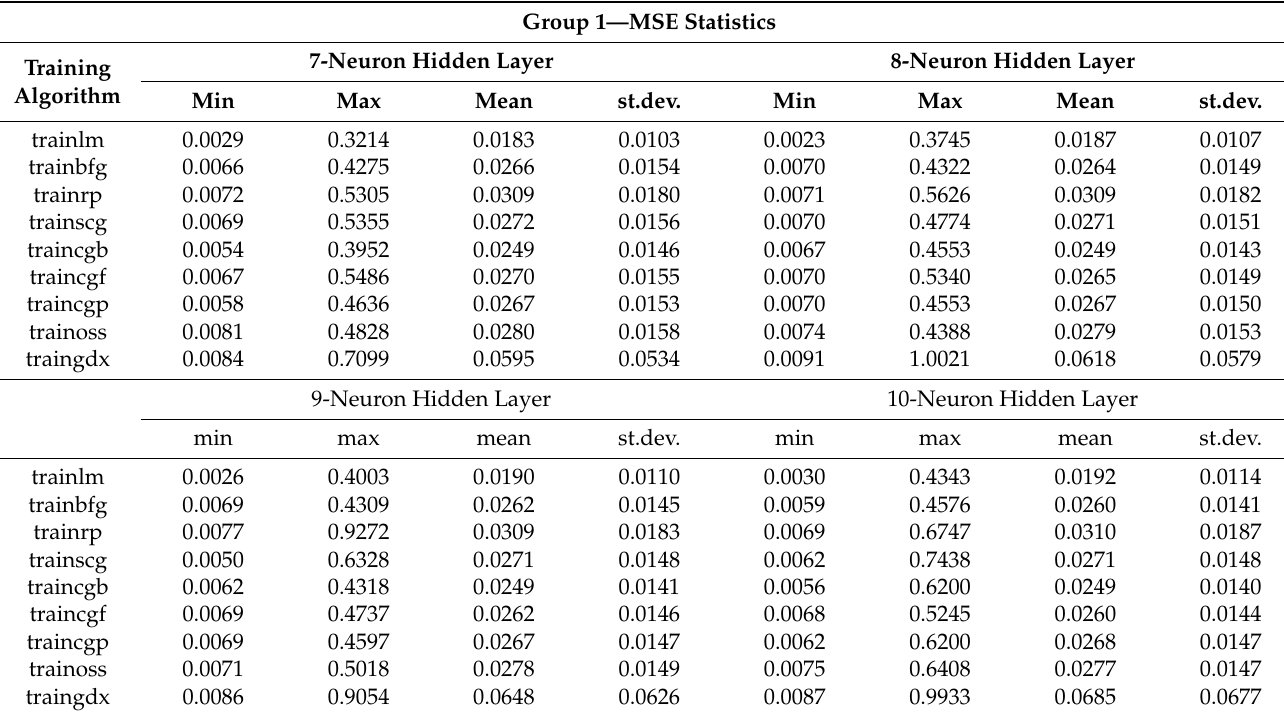
Table 5. Statistics of MSE—ANNs with input parameters of Group 1.